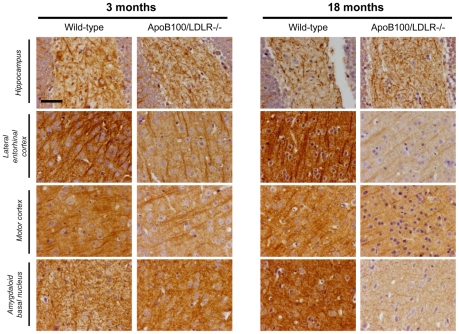
Lipid peroxidation in young and aged wild-type and transgenic mice.HNE stains of coronal sections (1.68 mm from bregma) of the left (contralateral) hemisphere of a mouse brain from each of the age/genotype different groups. The hippocampus and three areas of the cortex are represented, showing several nuclei of the temporal lobe cortex, such as the lateral entorhinal, the ectorhinal, perirhinal and temporal-association cortices, the primary and secondary somatosensory cortices, the lateral parietal association cortex and visual cortex, and the cortical amygdaloidal nucleus and amygdalohippocampal area. Scale bar: 25 µm.